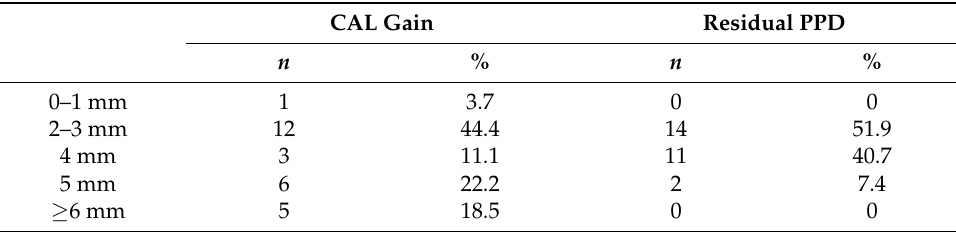
Table 3. Frequency distribution of CAL gains and residual PPD after 6